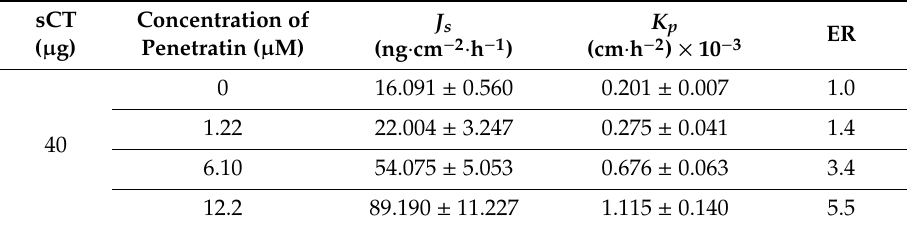
Table 2. TEER value for formulations before and after permeability experiments through TR146 cell layers.